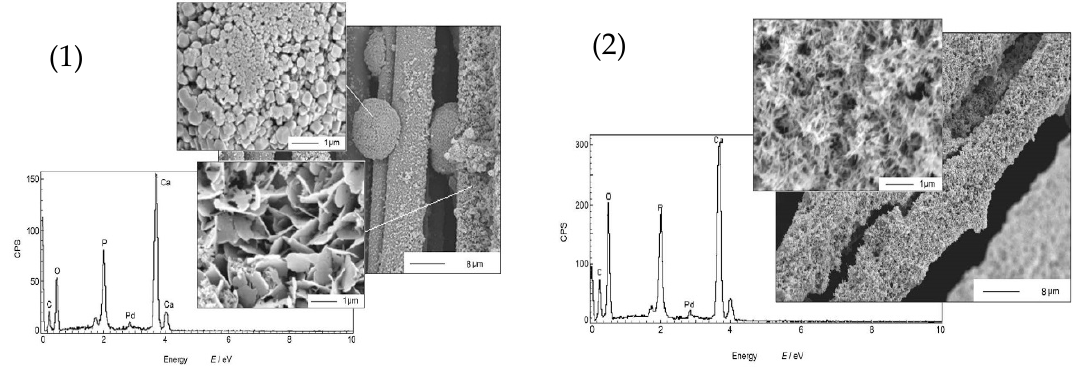
Figure 5. Morphologies and composition of CaP obtained by: (1) electrodeposition in the absence of sonication vs. (2) sonoelectrodeposition. Reprinted from [30] with permission from Elsevier.